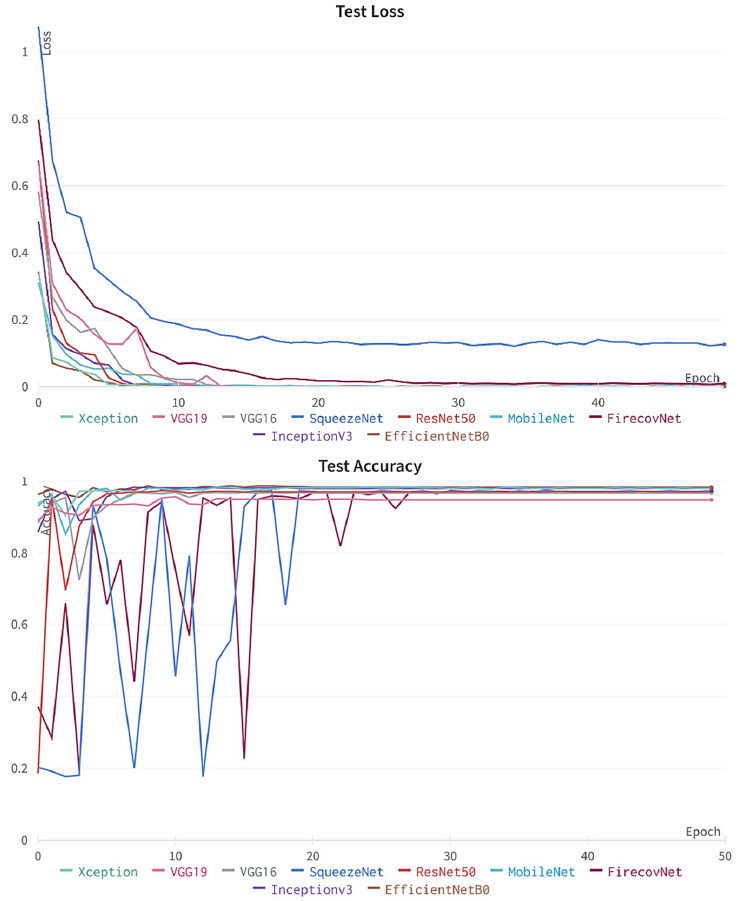
Figure 8. Accuracy and loss plots of proposed network comparing with other networks over 50 epochs for 5 ‐ class classification (5th fold).